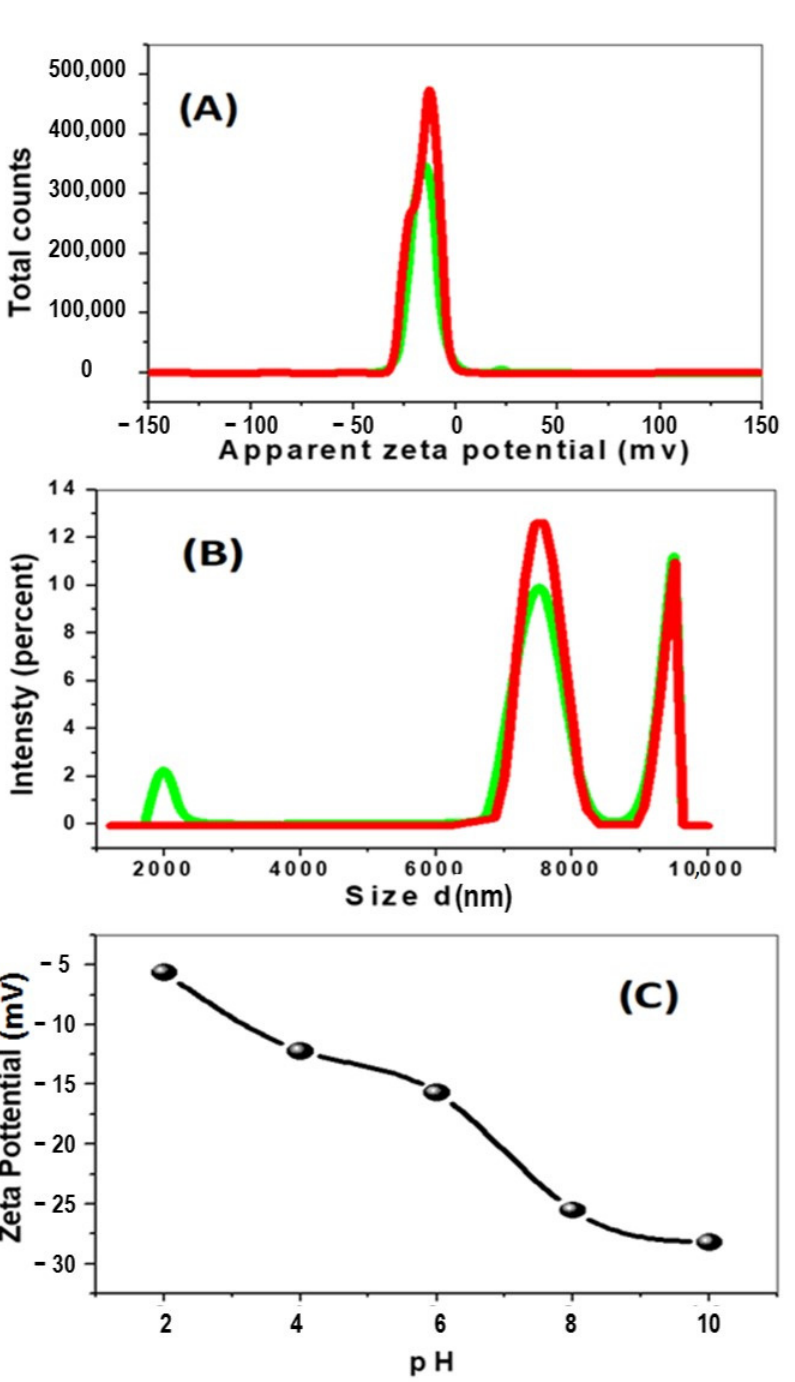
Figure 3. Zeta potential ( A ), particle size ( B ) of the ZnO–Ag/PPy nanocomposite, and ( C ) the effect of pH value on zeta potential.